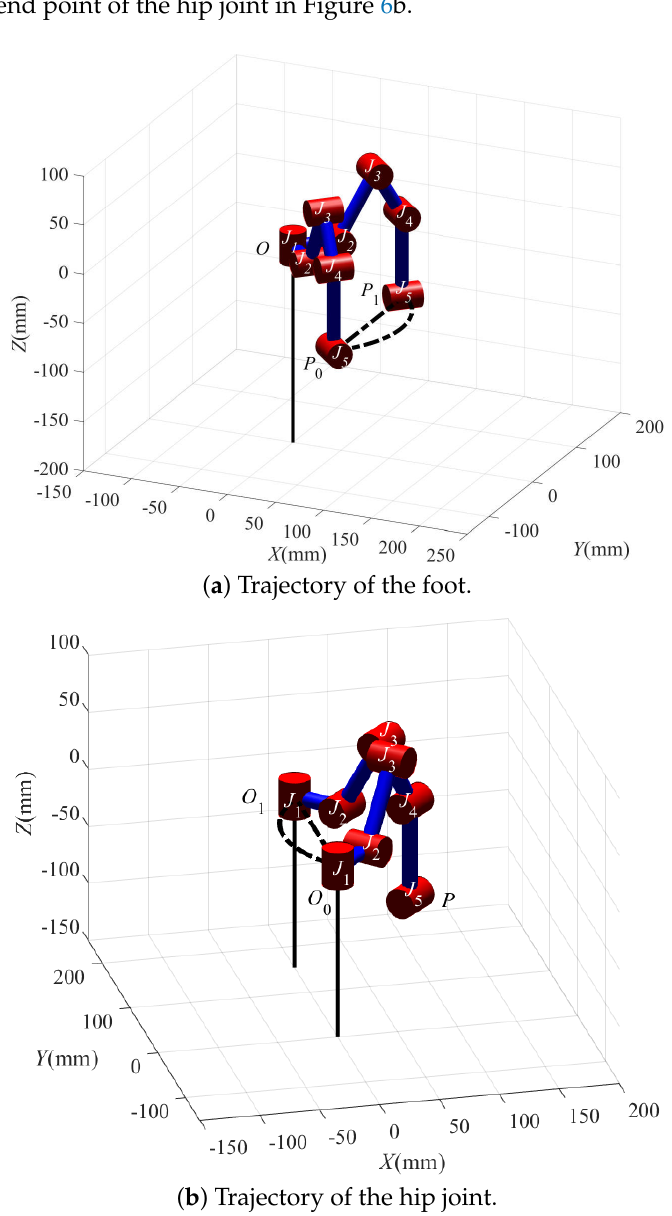
Figure 6. Trajectory planning in support